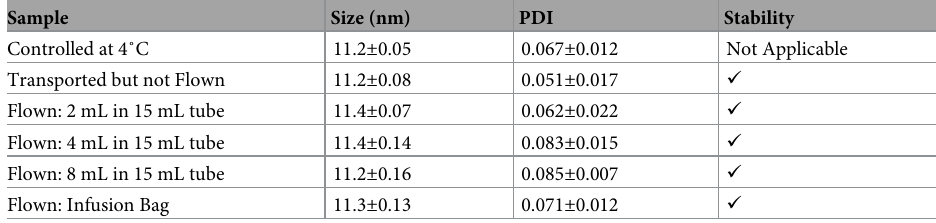
Table 3. Summary of DLS result of Trastuzumab at different storage conditions.